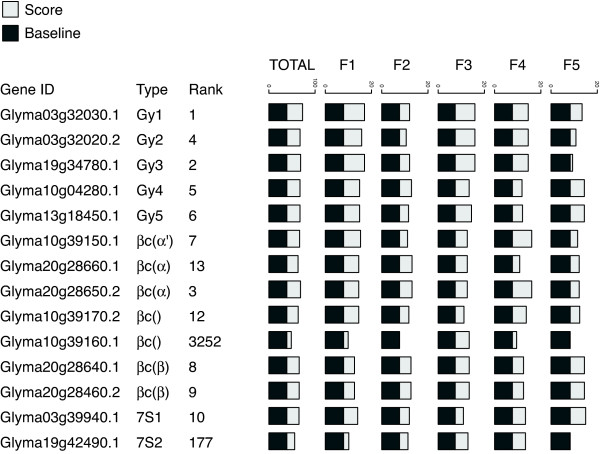
PWM score and rank of Fabaceae SSP gene promoter motifs in 14 soybean SSP gene promoters. The PWM matrix score associated with Fabaceae SSP gene promoter motifs in 14 soybean SSP gene promoters is compared to the average score obtained in 66,155 soybean promoters (baseline). Gy (1-5), glycinin subunit (1-5); βc (α', α, β), β-conglycinin subunit (α', α, β).